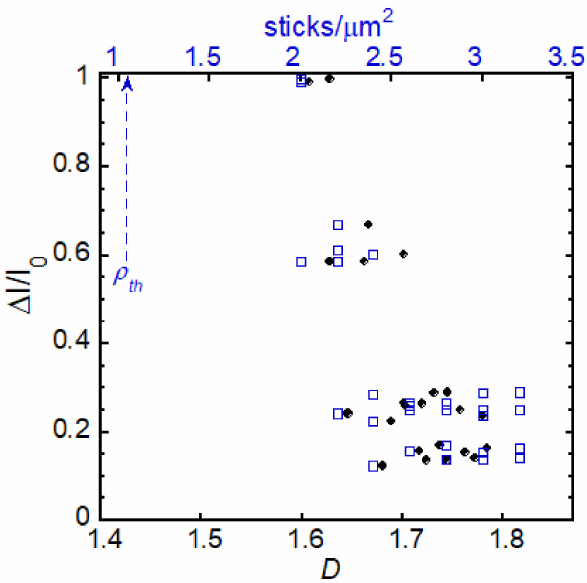
Figure 6. Normalized change in current as a function of fractal dimension, D , and CNT density for networks close to the percolation threshold, indicated with the blue dashed